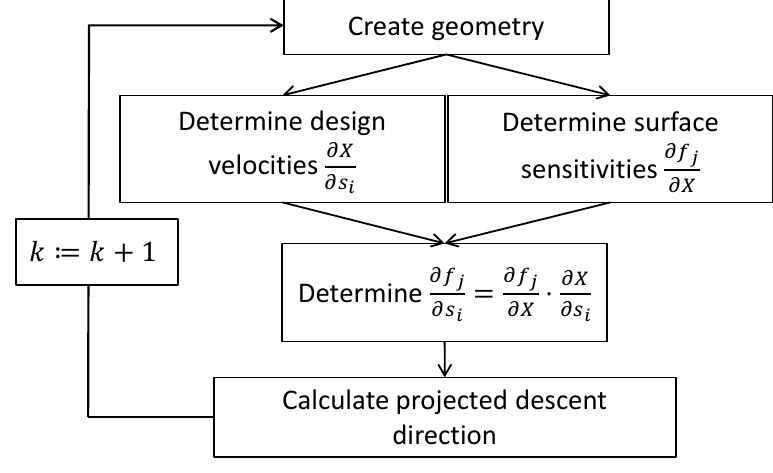
Figure 10. Gradient-based optimization